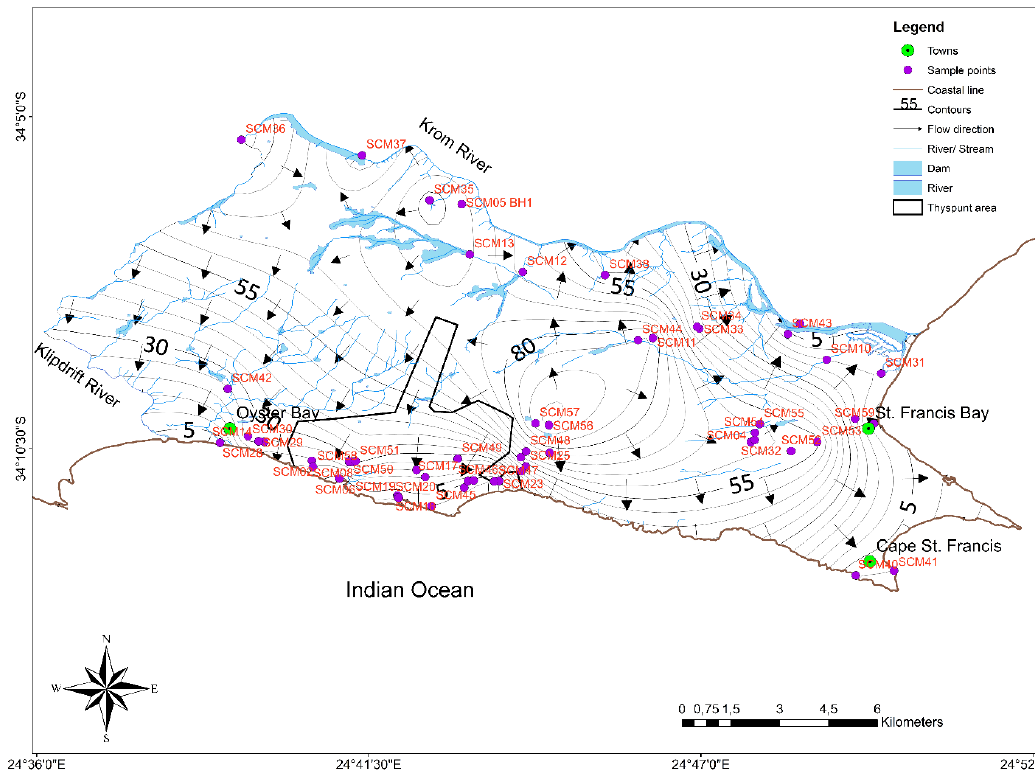
Figure 7. Groundwater level and flow map.